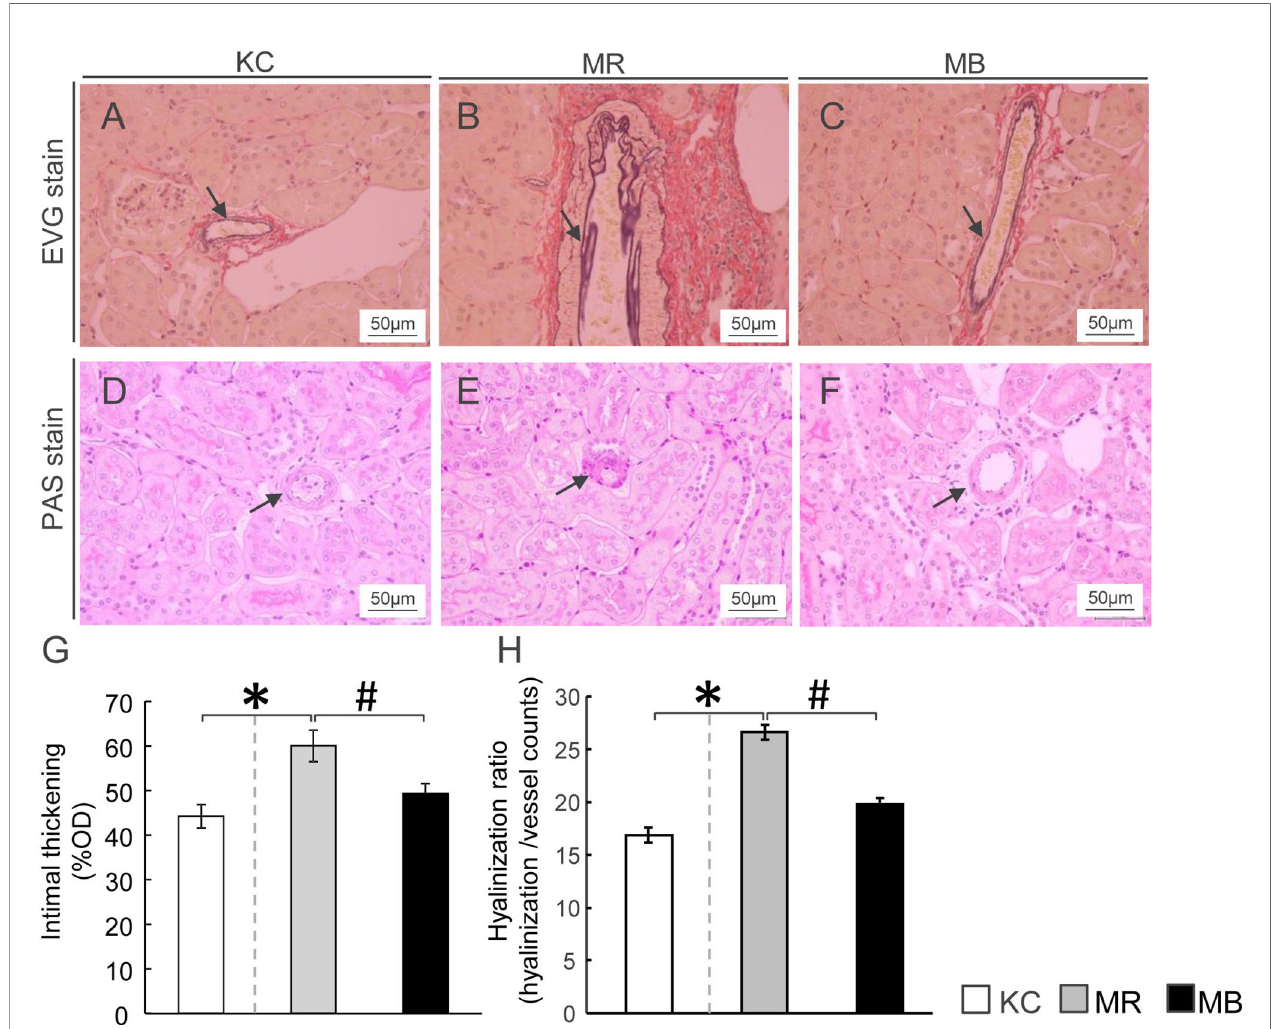
FIGURE 3 | Histopathology showing renal arteriolar intimal thickening and hyalinosis in the kidneys of mice after 10 weeks of experimental diet intake. (A – C) Glomerular fi brosis observed using Elastica van Gieson staining (arrow) (scale bar, 50µm) in mice from the three groups. (D – F) Renal arteriolar hyalinosis observed using Periodic acid – Schiff staining (arrow) (scale bar, 50 m m) in mice from the three groups. (G, H) Quanti fi cation of arteriosclerosis ratio (%OD) by fi bro-intimal thickening/vascular media (G) and hyalinization of the intrarenal vasculature (H) . OD, outer diameter; MB, minimum essential medium (MEM) mice on a barley diet; MR, MEM mice on a rice diet; KC, potassium simplex optimized medium control mice on a rice diet. Data are expressed as the mean ± SEM for 8 – 12 animals. Data were analyzed using Student ’ s t -test. * P < 0.05 compared with the KC group; # P < 0.05 compared with the MR